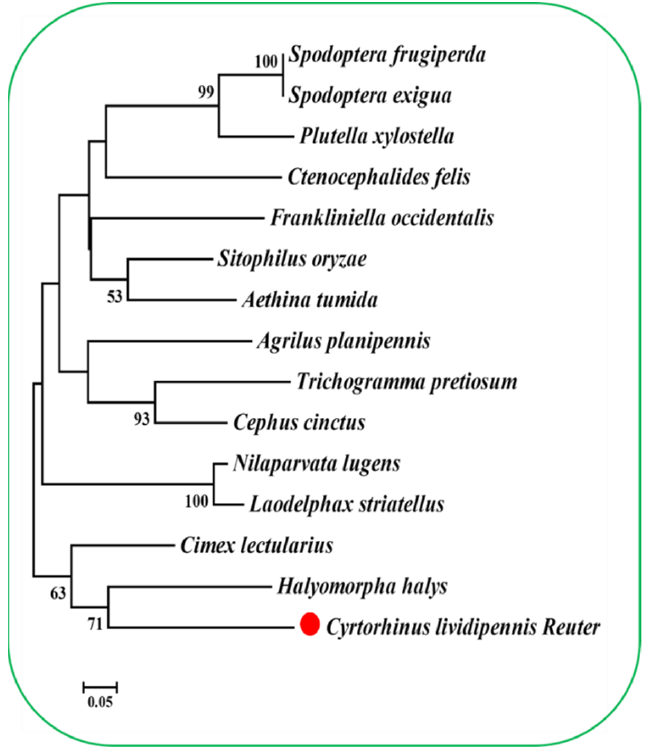
Figure 2. The phylogenic analysis of phosphoserine phosphatases (PSPs). An unrooted phylo- genetic tree is constructed by the maximum-likelihood method based on the protein sequence alignments. The PSP-like sequences originate from hemipteran species Cyrtorhinus lividipennis , Cimex lectularius (XP_024081153), Halyomorpha halys (XP_014271743), Nilaparvata lugens (AGG09860), and Laodelphax striatellus (AGC92248); coleopteran species Agrilus planipennis (XP_01833970), Aethina tumida (XP_019877426), and Sitophilus oryzae (XP_030747197); lepidopteran species Plutella xylostella (NP_001296070), Spodoptera frugiperda (XP_035439715), and Spodoptera exigua (KAF9423892); hy- menopteran species Cephus cinctus (XP_024943432) and Trichogramma pretiosum (XP_014230438); siphonaptera species Ctenocephalides felis (XP_026462493); and thysanoptera species Frankliniella occi- dentalis (KYP96486.1). The bootstrap value (1000 replicates) for each node is shown. The scale bar corresponds to a distance of 0.05. The scale bar represents the amino acid divergence. The red point represents C. lividipennis Reuter